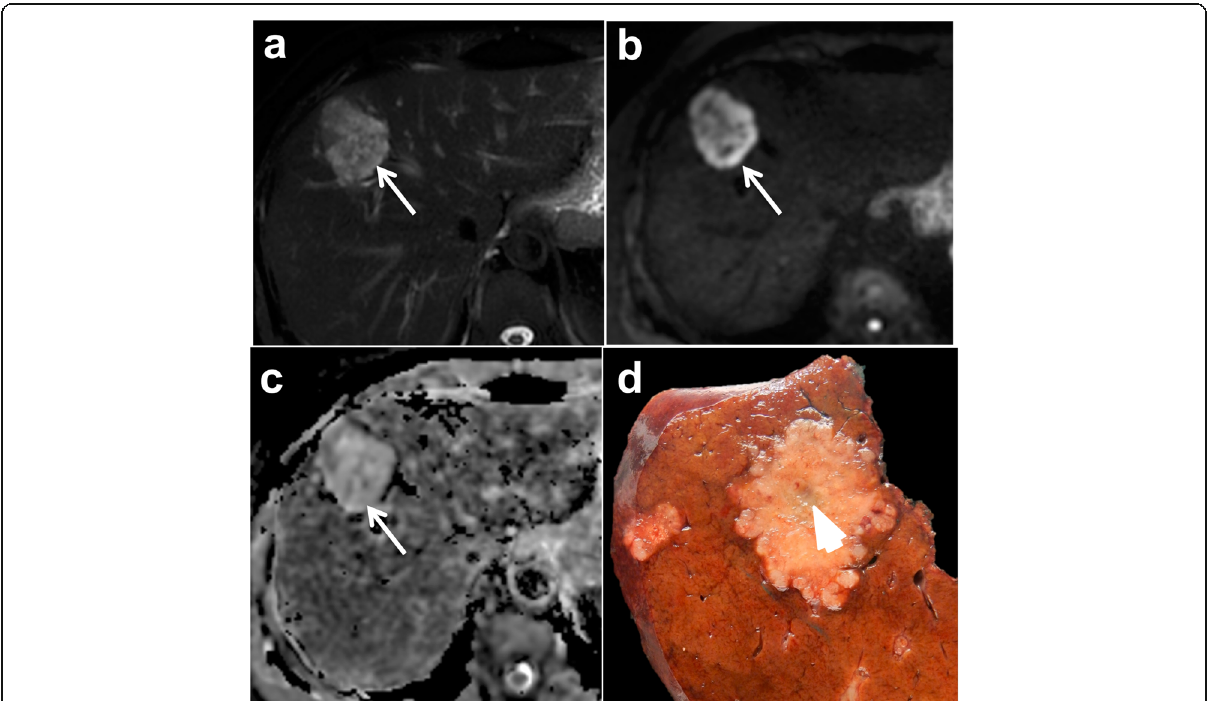
Fig. 13 Example of mucinous regression of a metastasis of non-otherwise specified (NOS) adenocarcinoma of the rectum in a 52-year-old male patient treated by chemotherapy followed by hepatic resection. On preoperative MR imaging the lesion (arrows) shows high signal intensity on the fat-saturated fast spin echo T2-weighted image ( a ) and the diffusion weighted image ( b 800 s/mm 2 ) ( b ). The apparent diffusion coefficient was high ( c ). Gross pathology ( d ) shows a polylobated metastasis with central mucinous regression, containing lakes of acellular mucine